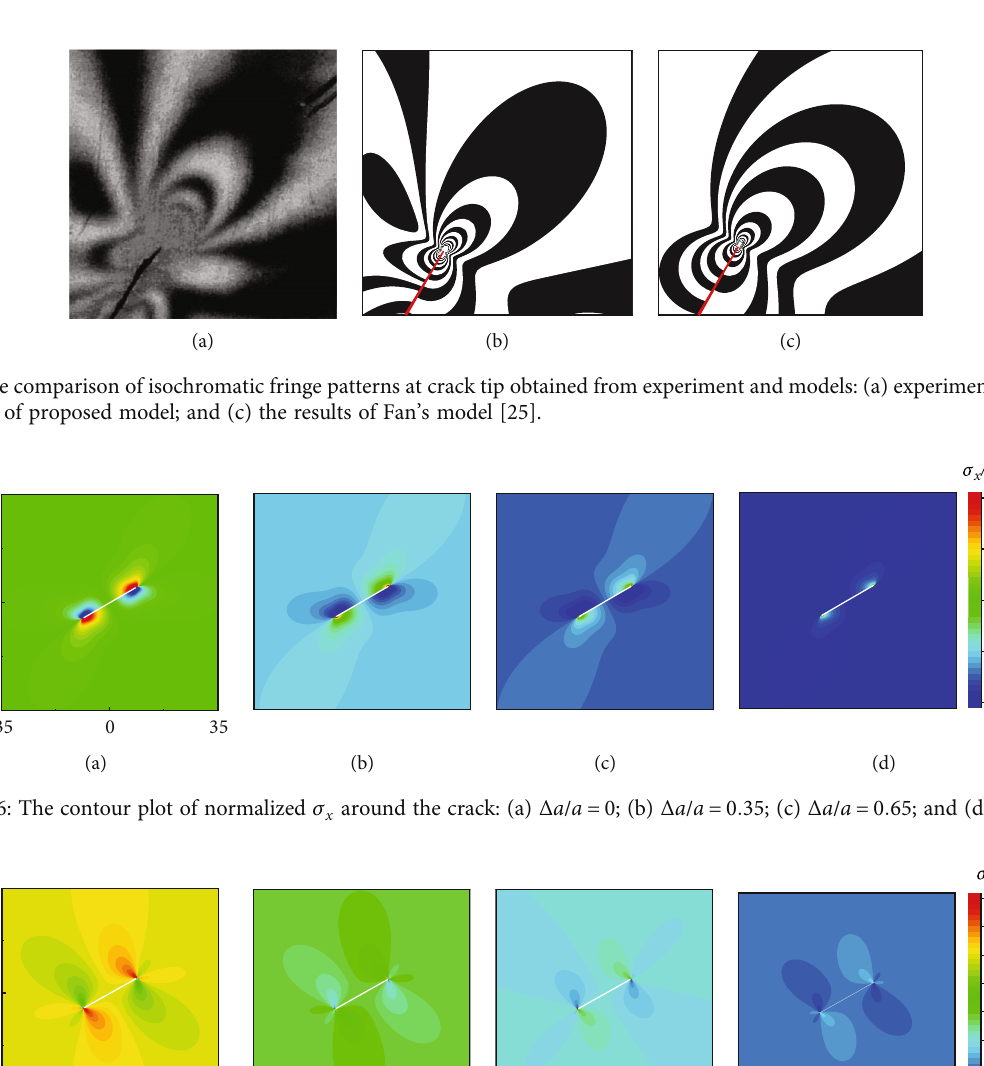
around the crack: (a) Δ a / a = 0 ; (b) Δ a / a = 0 : 35 ; (c) Δ a / a = 0 : 65 ; and (d) Δ a / a = 1 . y